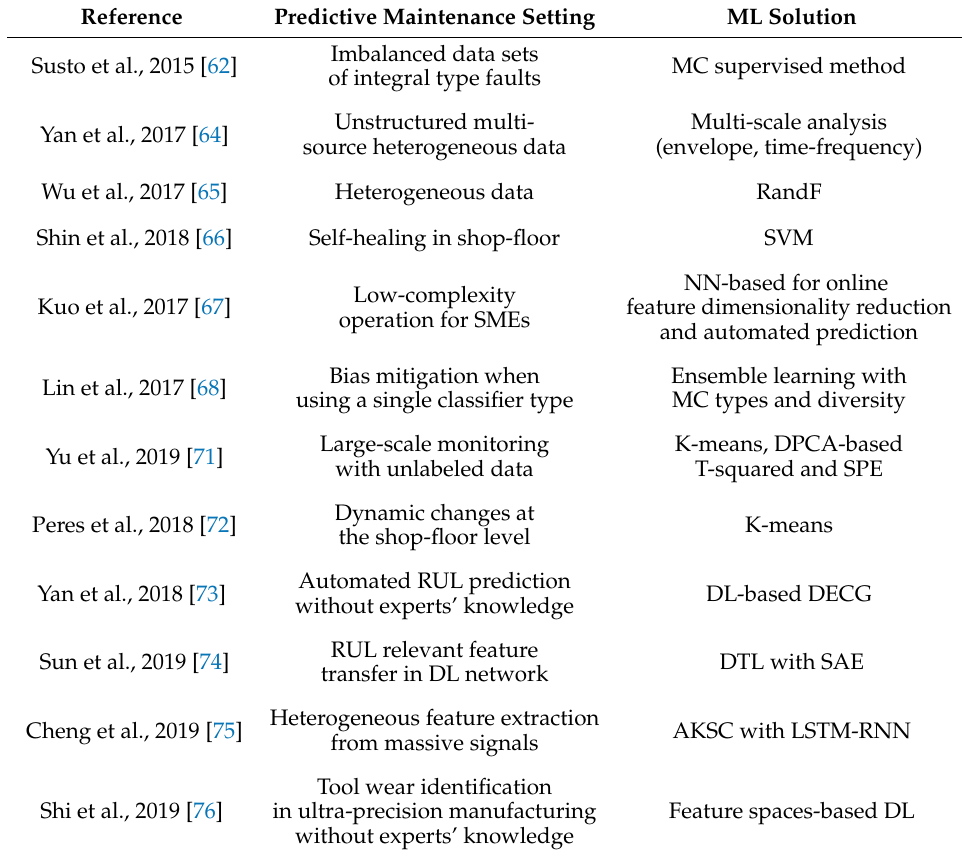
Table 4. Predictive maintenance setting and respective ML solutions for Industry